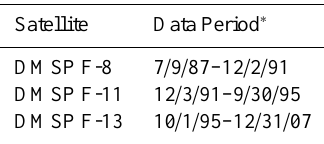
Table 1. Sources and data periods of passive microwave sensors for NOAA / NSIDC sea ice concentration